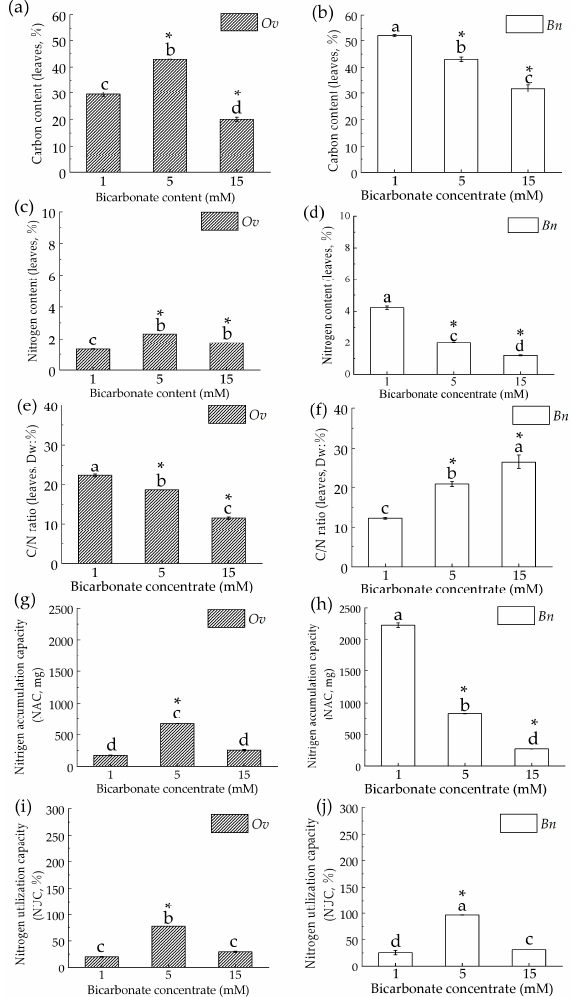
Figure 3. The content of the carbon/nitrogen component in leaves between Ov and Bn at different bicarbonate levels. Ov—Orychophragmus violaceus and Bn—Brassica napus . ( a , b )—The carbon content of Ov / Bn , ( c , d )—The nitrogen content of Ov / Bn , ( e , f )—The C/N ratio of Ov / Bn , ( g , h )—The NAC of Ov / Bn , ( i , j )—The NUC of Ov / Bn . The ratio of nitrate/ammonium within consistent total nitrogen concentration was 14 mM:1 mM under various bicarbonate treatments. Each value represents the mean ± SD ( n = 3), and diverse letters with “*” in each value are significantly different by ANOVA ( p > 0.05).